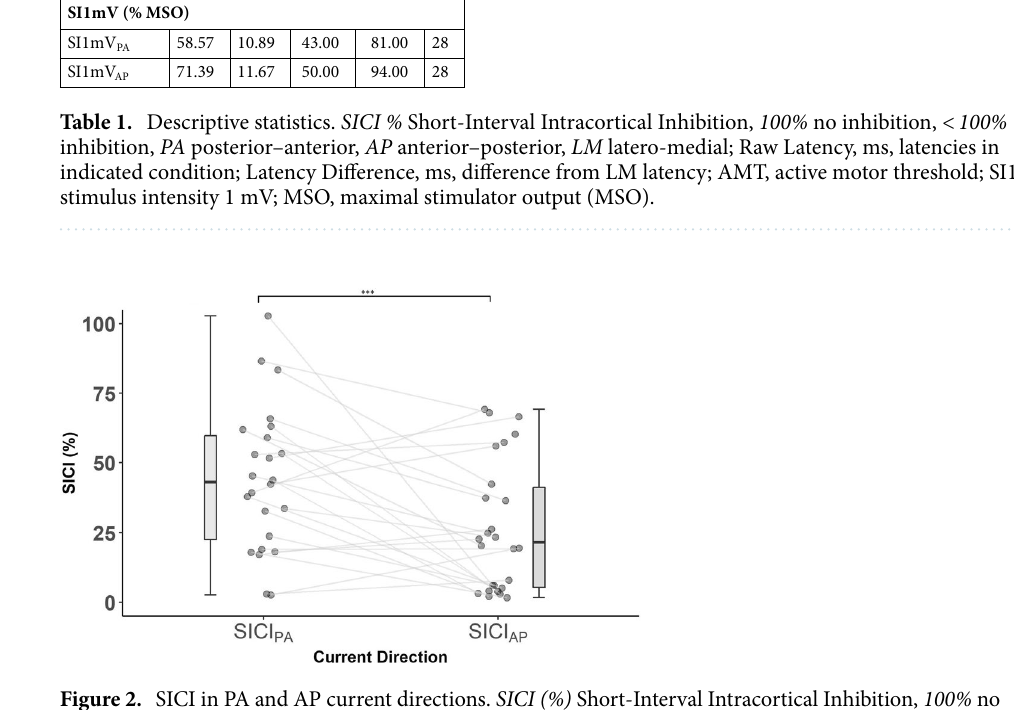
Figure 2. SICI in PA and AP current directions. SICI (%) Short-Interval Intracortical Inhibition, 100% no inhibition, < 100% inhibition; Current Direction, PA posterior–anterior, AP anterior–posterior. Boxplots showing medians and IQR; *** p <